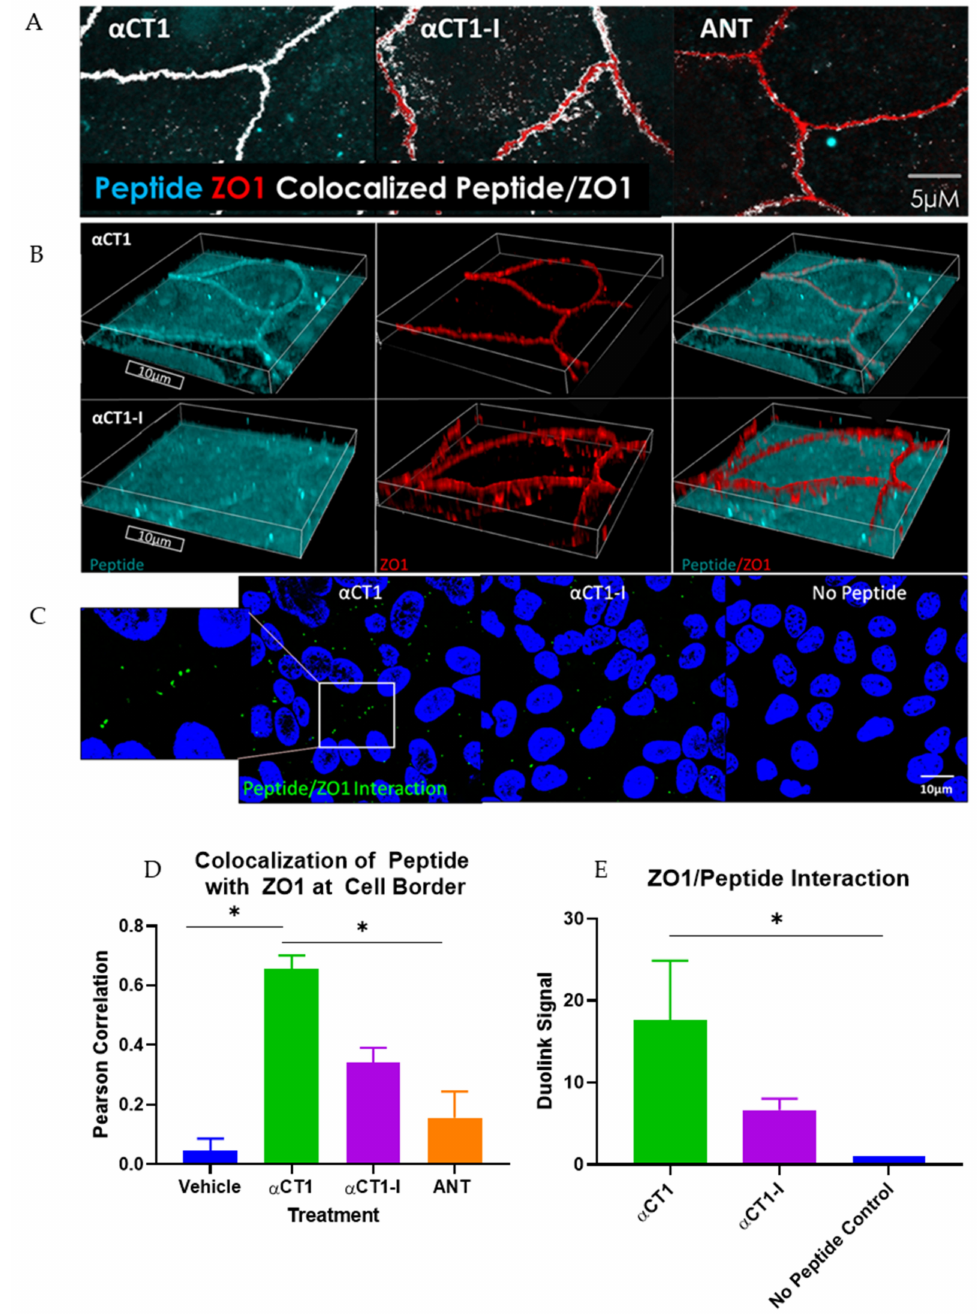
Figure 2. α CT1 requires its terminal isoleucine to associate with ZO1 inside Cx43-deficient MDCK cells. ( A ) Representative confocal images of colocalization (white) between α CT1 and ZO1 binding- deficient control, α CT1-I, and cell penetration sequence control, antennapedia (ANT). ( B ) Rep- resentative volumetric 3D confocal image renderings of border localization of α CT1 vs. α CT1-I. ( C ) Representative confocal images of the Duolink interaction between peptides and ZO1. Green spots represent points of interaction. ( D ) Quantification of colocalization between the peptides and ZO1, as determined by Pearson Correlation analysis. ( E ) Quantification of the Duolink interaction between the peptides and ZO1. * p < 0.05 vs. controls; N =